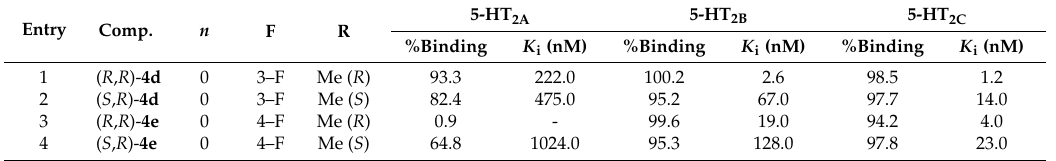
Table 2. Binding affinities of optically active pyrimidines 4d and 4e against 5-HT 2 receptor subtypes